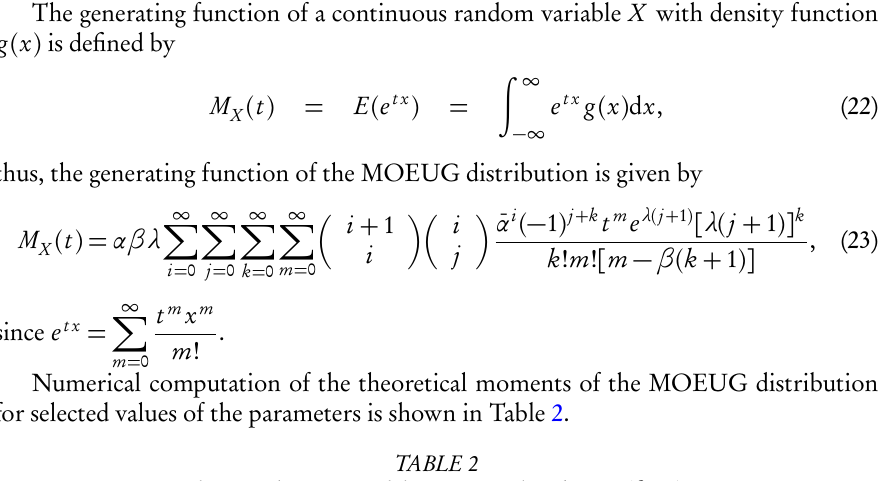
Theoretical Moments of the MOEUG distribution ( β =